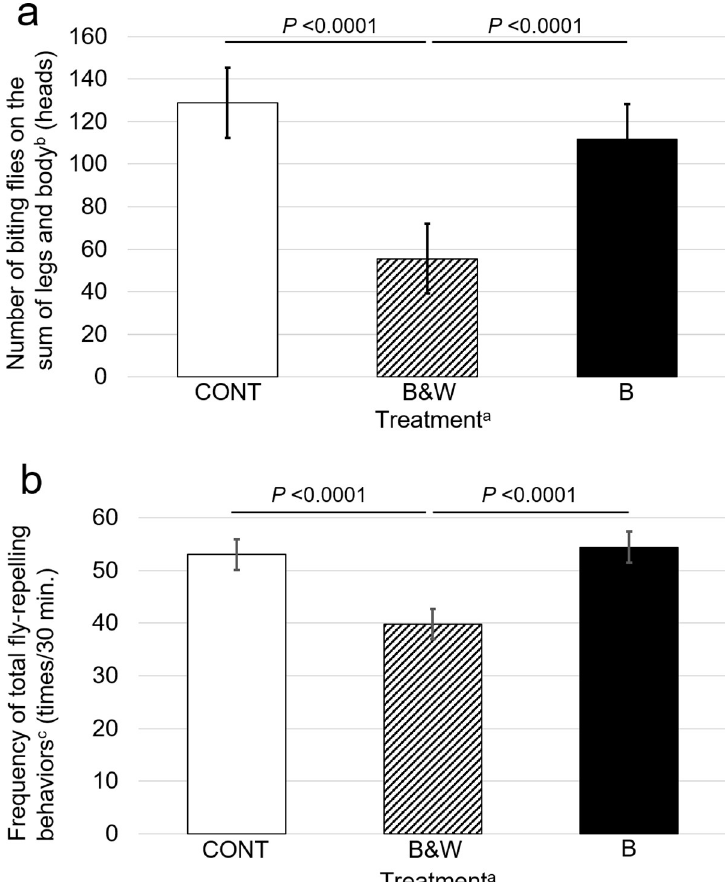
Fig 3. Number of biting flies on legs and body (a) and the frequency of total fly-repelling behaviors (b) of the experimental cows. a CONT: no stripe cattle, B&W: black-and-white striped cattle with white lacquer, which indicates “striped-cattle” indicates “striped-horse (zebra)” in Japanese), B: black-striped cattle with black lacquer. b Biting flies trapped by the sticky plastic boards were mainly stable flies ( Stomoxys calcitrans ), a few horn flies ( Haematobia irritans ), and horse flies ( Tabanus sapporoensis ). These flies are popular in Japan [21–24]. The relative abundance of these biting flies were Stomoxys calcitrans (77.9%), Haematobia irritans (21.5%), and Tabanus sapporoensis (0.5%). c Head throws, ear beats, leg stamps, skin twitches and tail